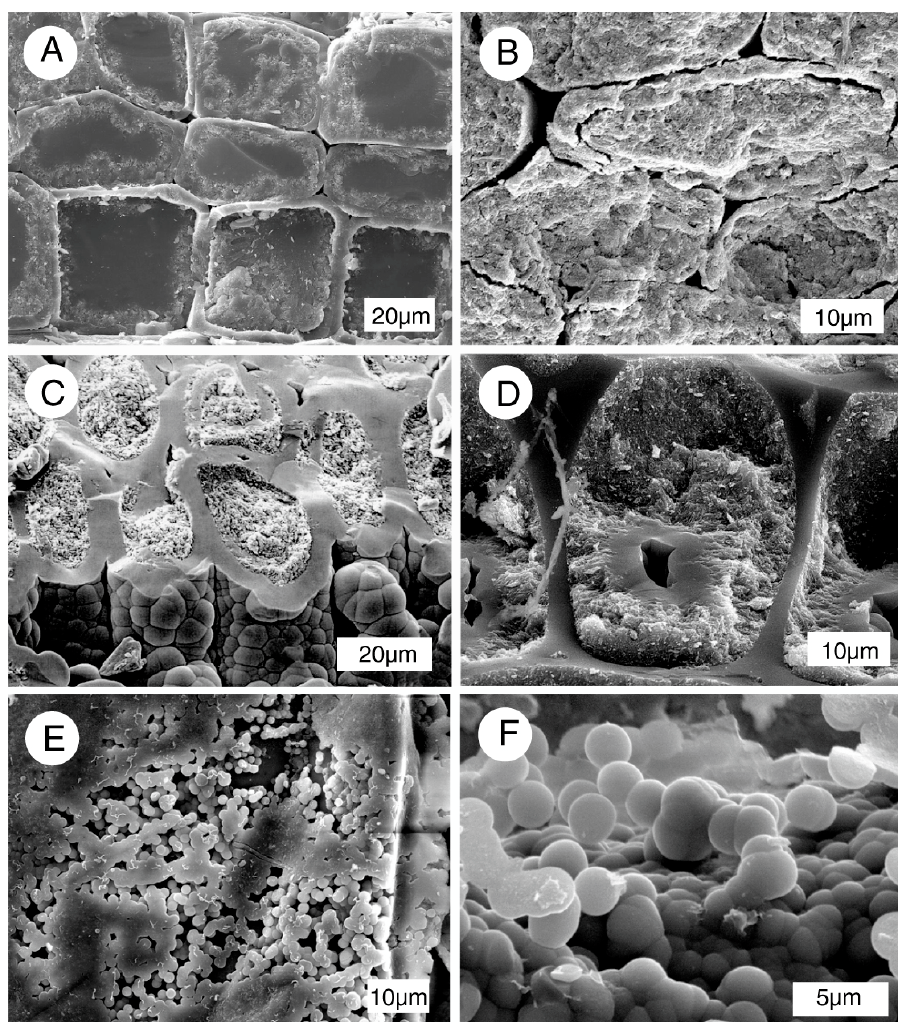
Figure 4. Mineralized cells, Miocene specimens showing opaline silica filling cell lumina and as a replacement for cell walls. ( A ) Bonanza Opal Mine, Virgin Valley, NV, USA. Transverse orientation, cell walls and lumina mineralized with opal-CT; ( B ) Norita Opal Mine, Virgin Valley, NV, USA. Transverse orientation, cells and lumina filled with opal-CT, intercellular spaces remain open; ( C ) Washoe County, NV, USA, oblique transverse orientation, cell walls mineralized with opal-A, lumen filled with porous opal; ( D ) Washoe County, NV, USA, oblique transverse orientation, cell walls mineralized with opal-A, lumina lined with amorphous porous opal, central area partially filled with botryoidal opal-A; ( E , F ) Hazen, NV, USA, radial orientation, cells mineralized with opal-A lepispheres. These lepispheres partially fill cell lumina, rather than replicating actual tissue.